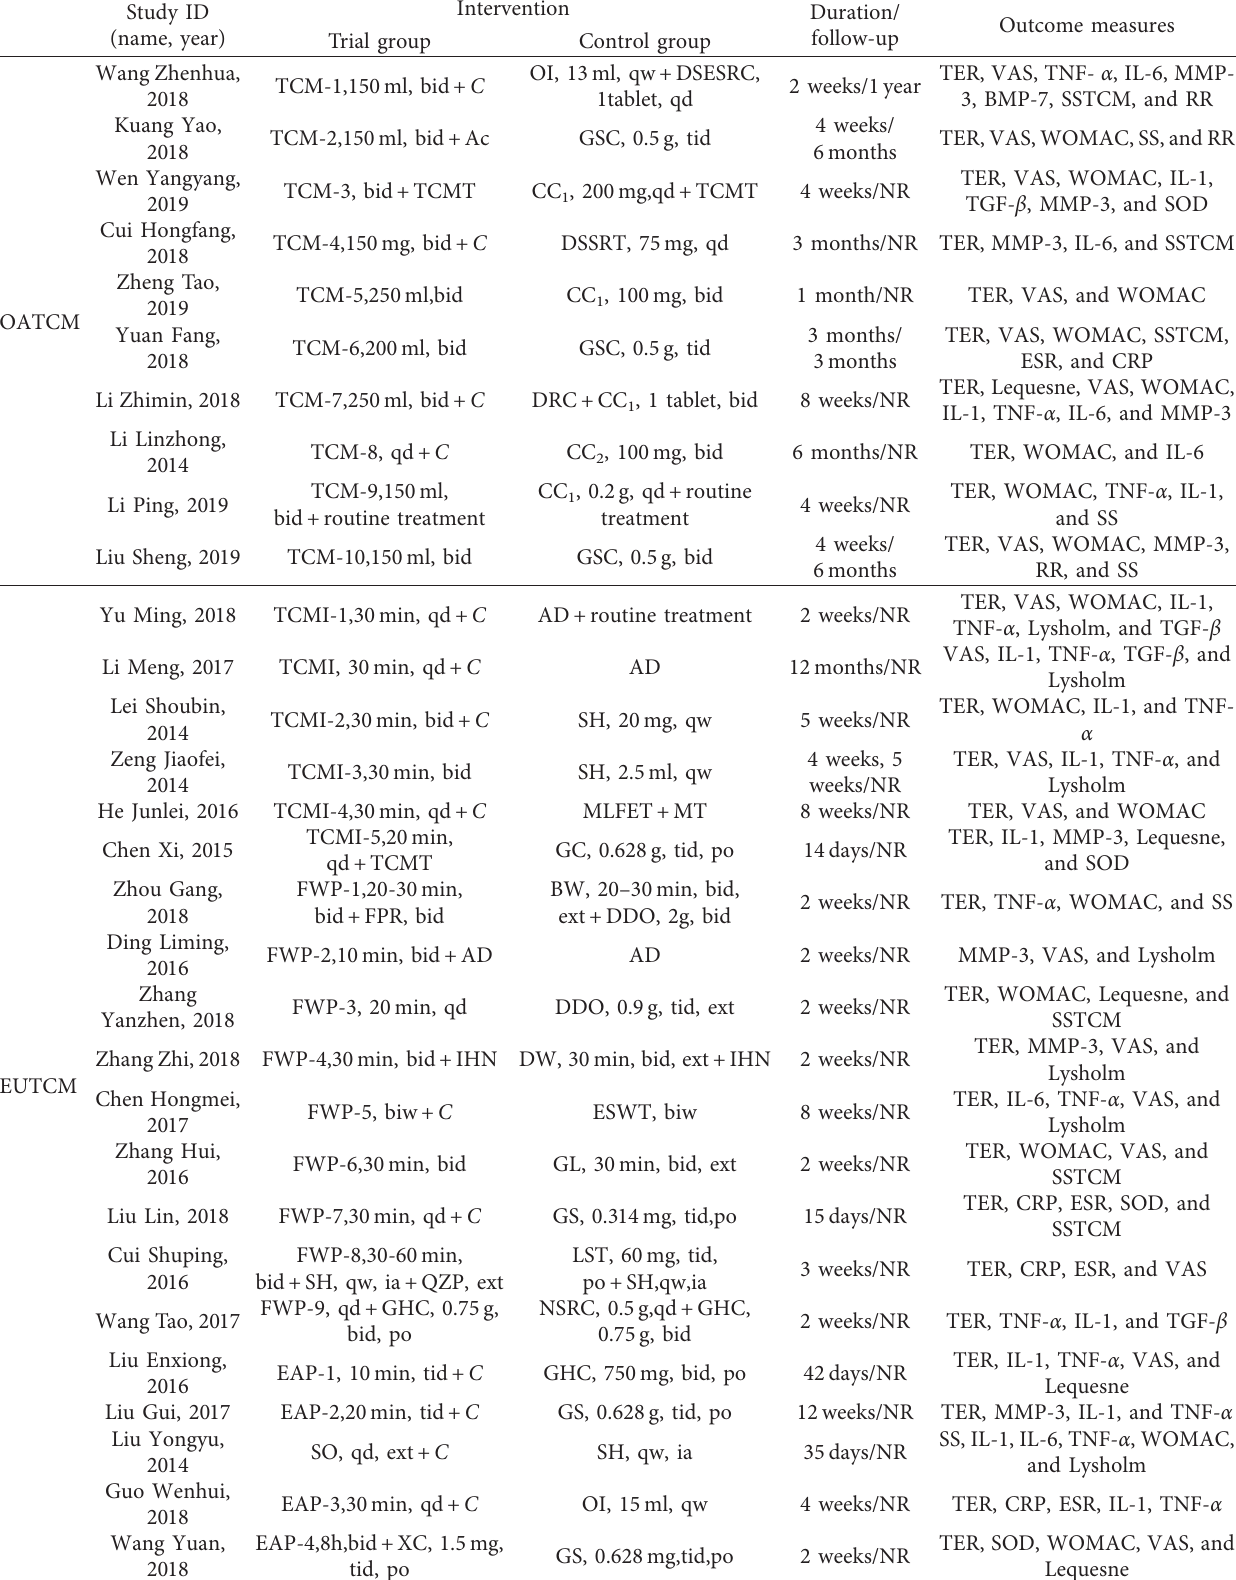
Table 2: Intervention characteristics of included